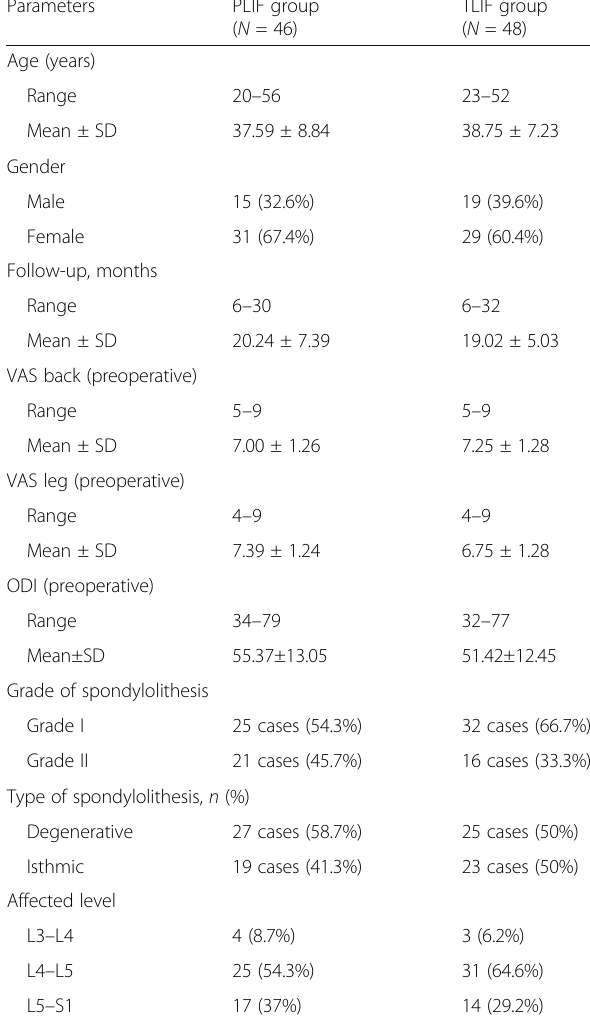
Table 1 Patients ’